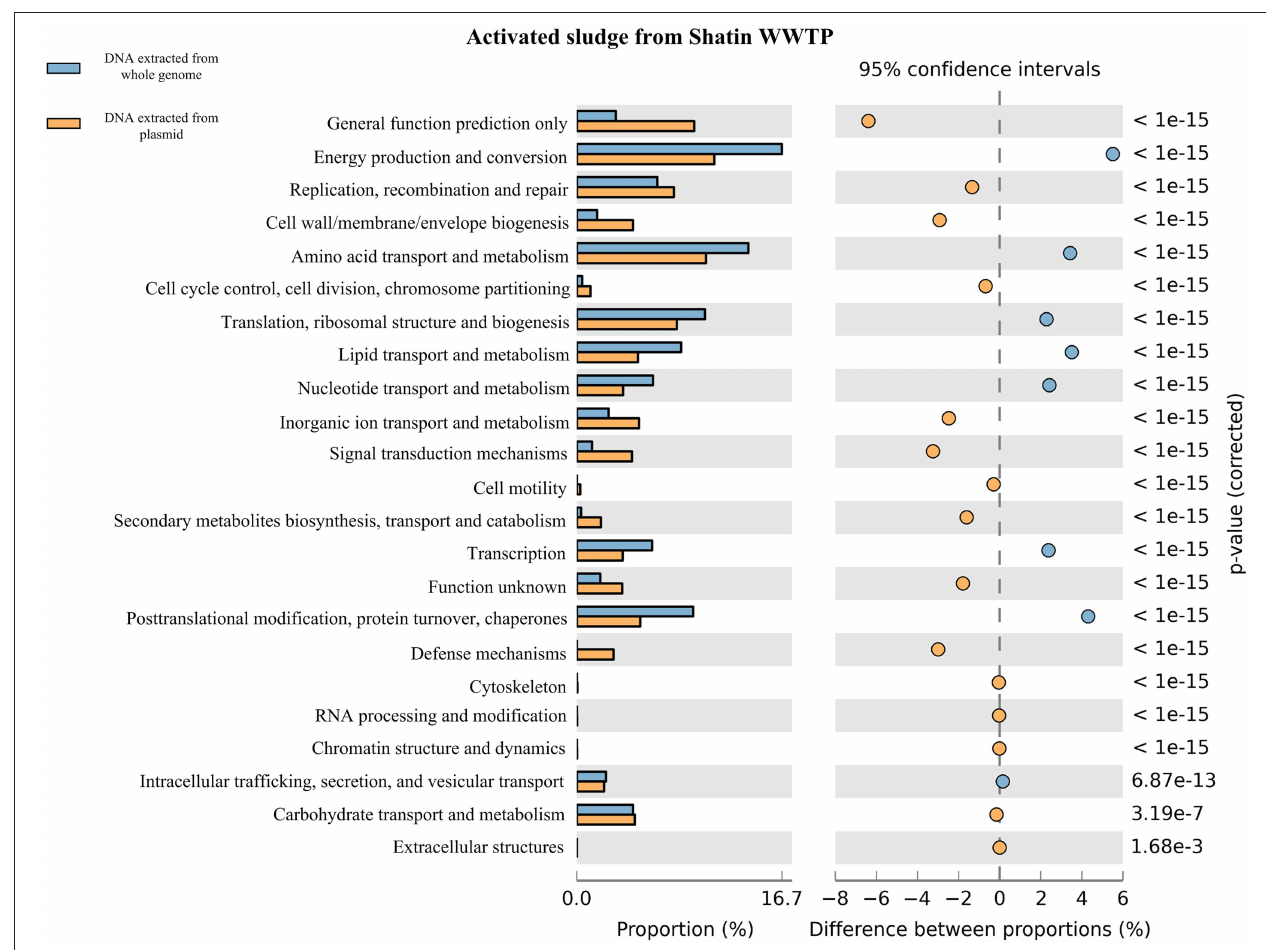
FIGURE 3 | Functional genes in the plasmid metagenome vs. the genes in the total DNA metagenome extracted from STAS based on the percentages of COG categorized genes and pairwise proportional differences calculated using STAMP (Statistical Analysis of Metagenomic